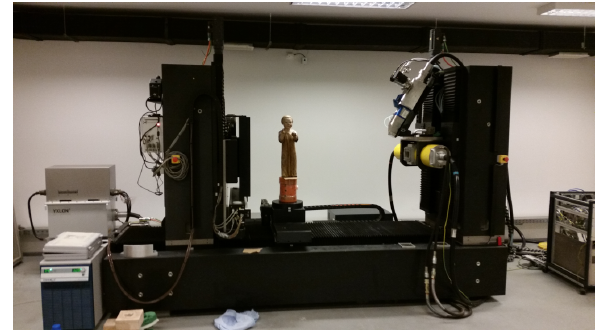
Figure 2: CT imaging of the wood sculpture